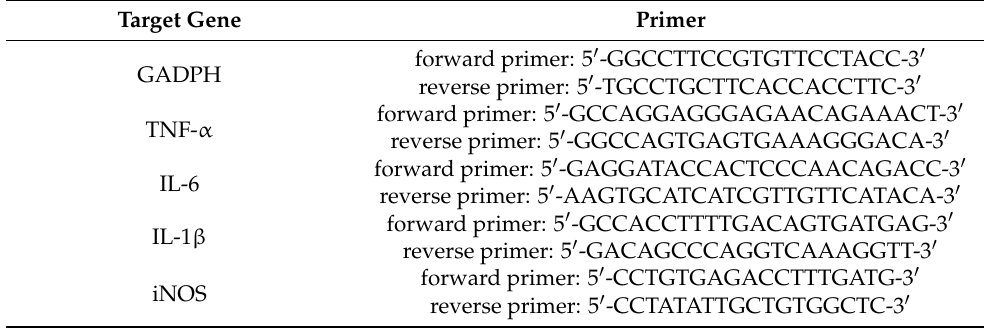
Table 3. PCR primers used in the measurement of mRNA